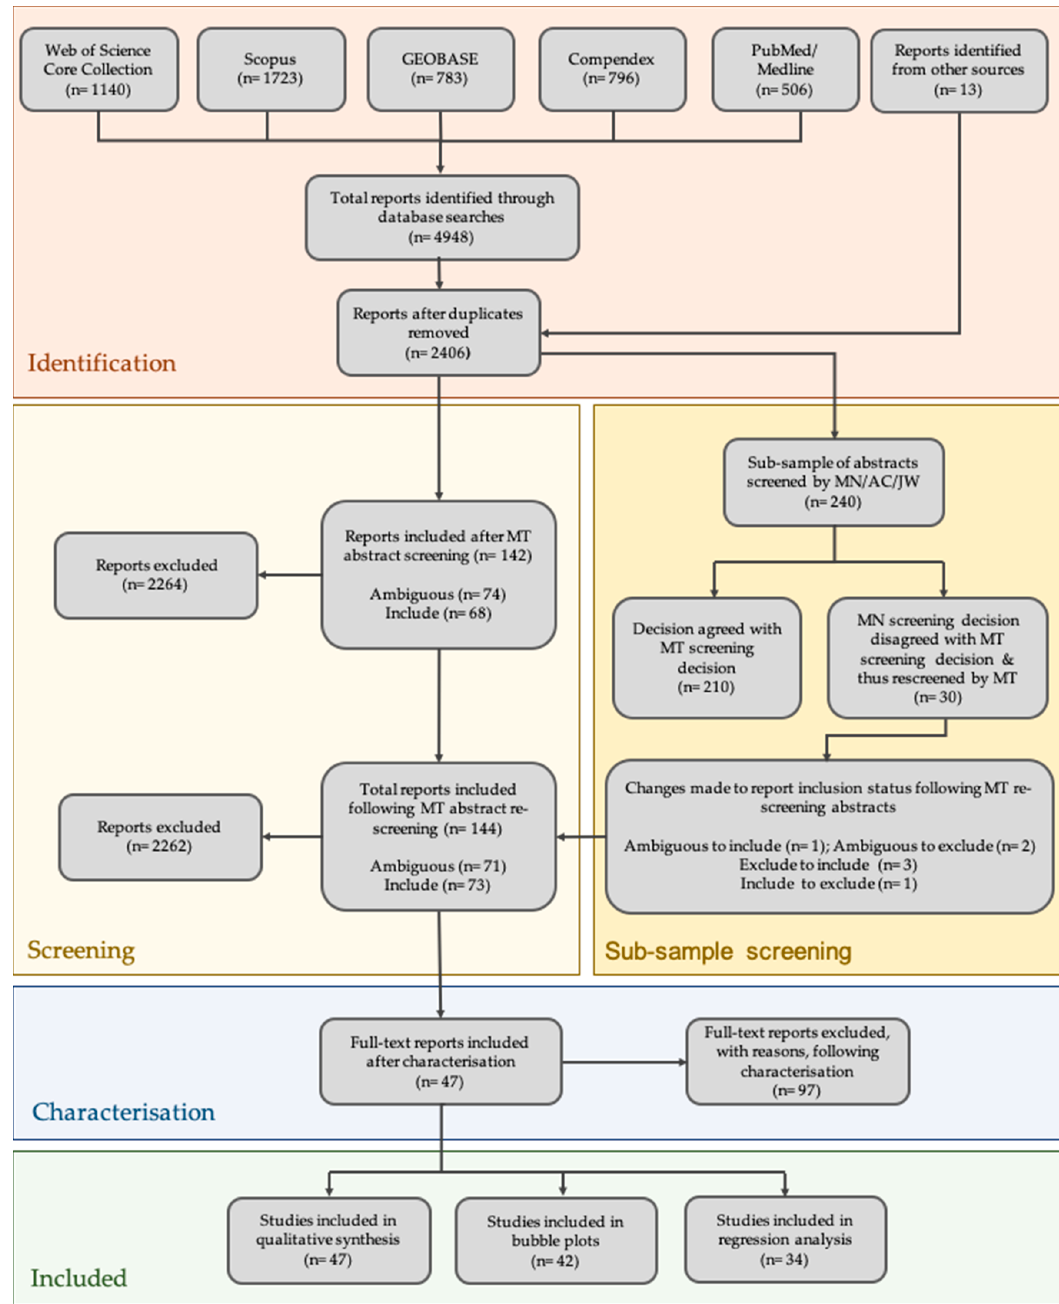
Figure 1. Flowchart of study selection process .